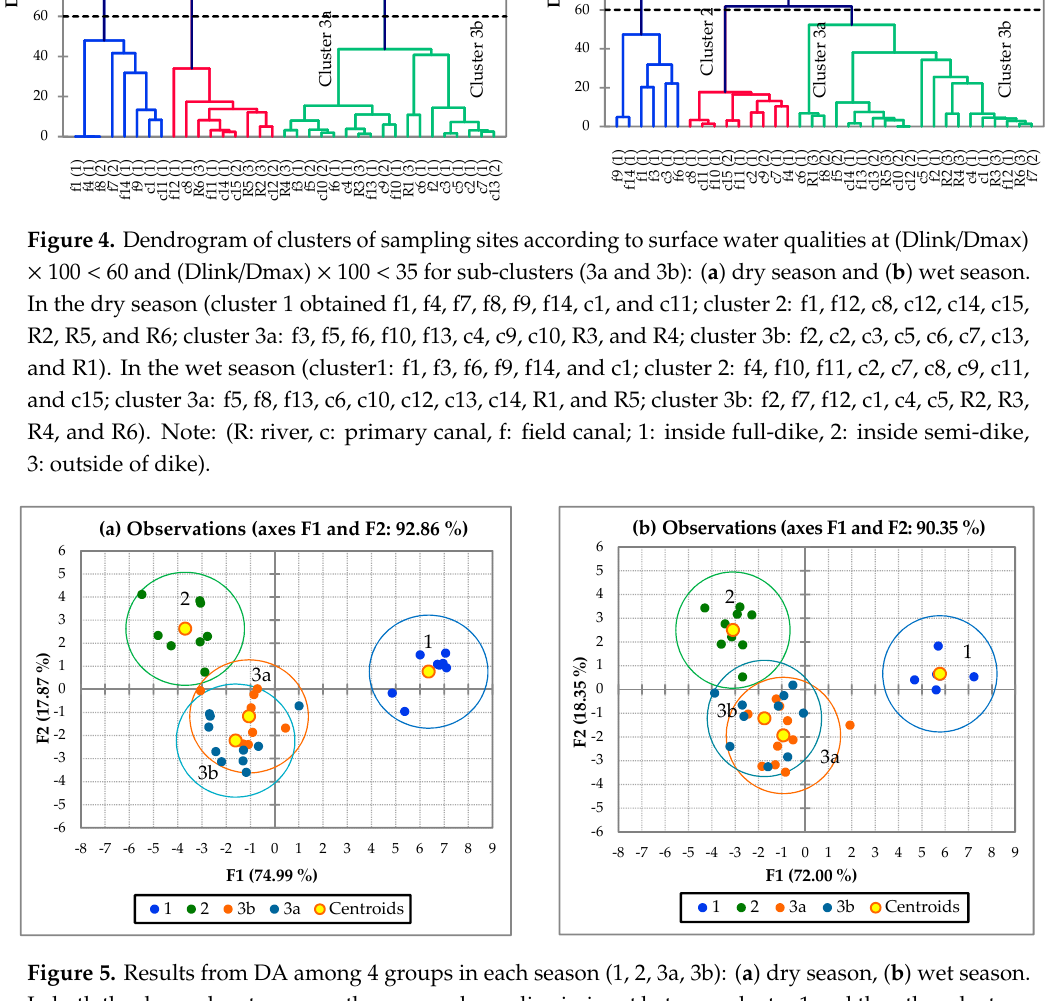
Figure 5. Results from DA among 4 groups in each season (1, 2, 3a, 3b): ( a ) dry season, ( b ) wet season. In both the dry and wet seasons, there was a large discriminant between cluster 1 and the other clusters, while cluster 3a and 3b had fewer discriminant features. In the dry season, F1 and F2 explained 74.99% and 17.87% of the total variation, respectively. In the wet season, F1 and F2 explained 72.01% and 18.35% of the total variation, respectively.